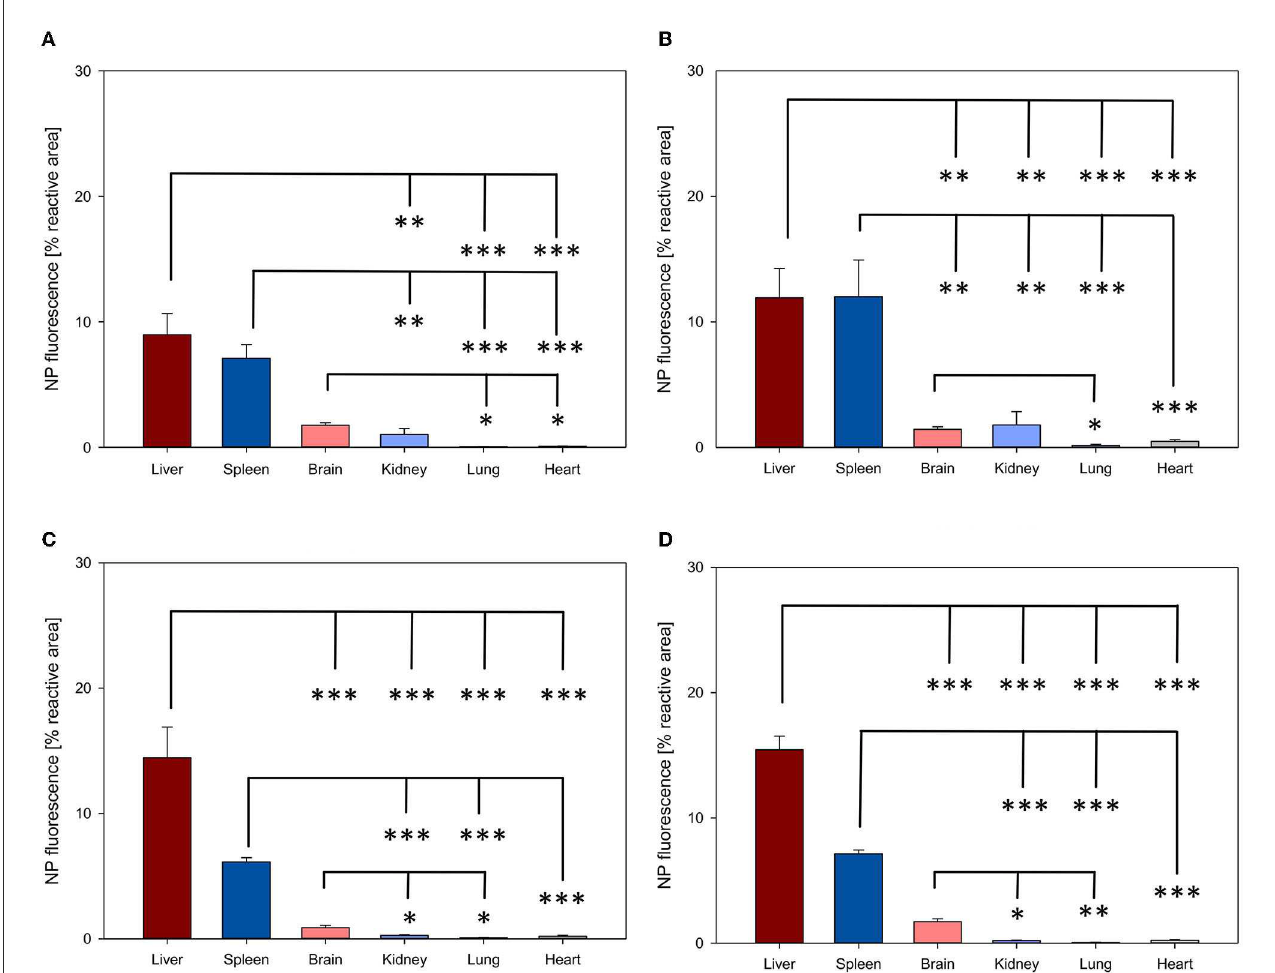
FIGURE4 Organ distribution of NP uptake 24h after intravenous injection. The accumulation of PFDL-Tw (A) , PFDL-SDS (B) , PLLA-Tw (C) , and PLLA-SDS (D) nanoparticles in all organs was assessed as the percentage of reactive fluorescent area in relation to the total area of the ROI at 40 × magnification. Overall, one-way ANOVAs showed higher NP uptake in the liver and spleen, followed by a moderate to low accumulation in the brain and the kidney and very low in the lung and the heart. Bars express means ± SEM. *** p < 0.001, ** p < 0.01, * p <